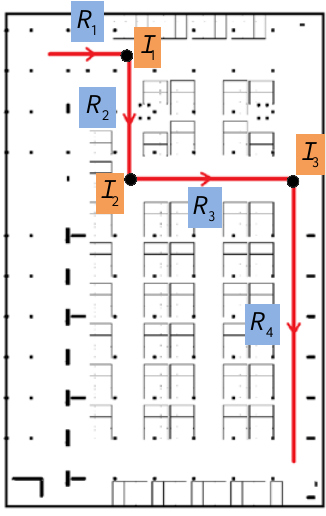
Figure 7. Example of connections between road segments. The red line is a user trace in an underground parking. R and I are respectively the road segments and connections in this trace.